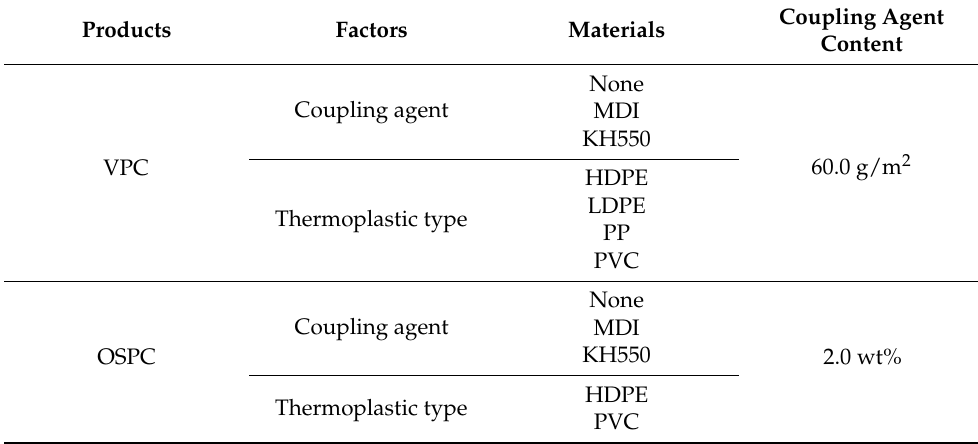
Table 1. Experimental design for fabrication of the VPC and